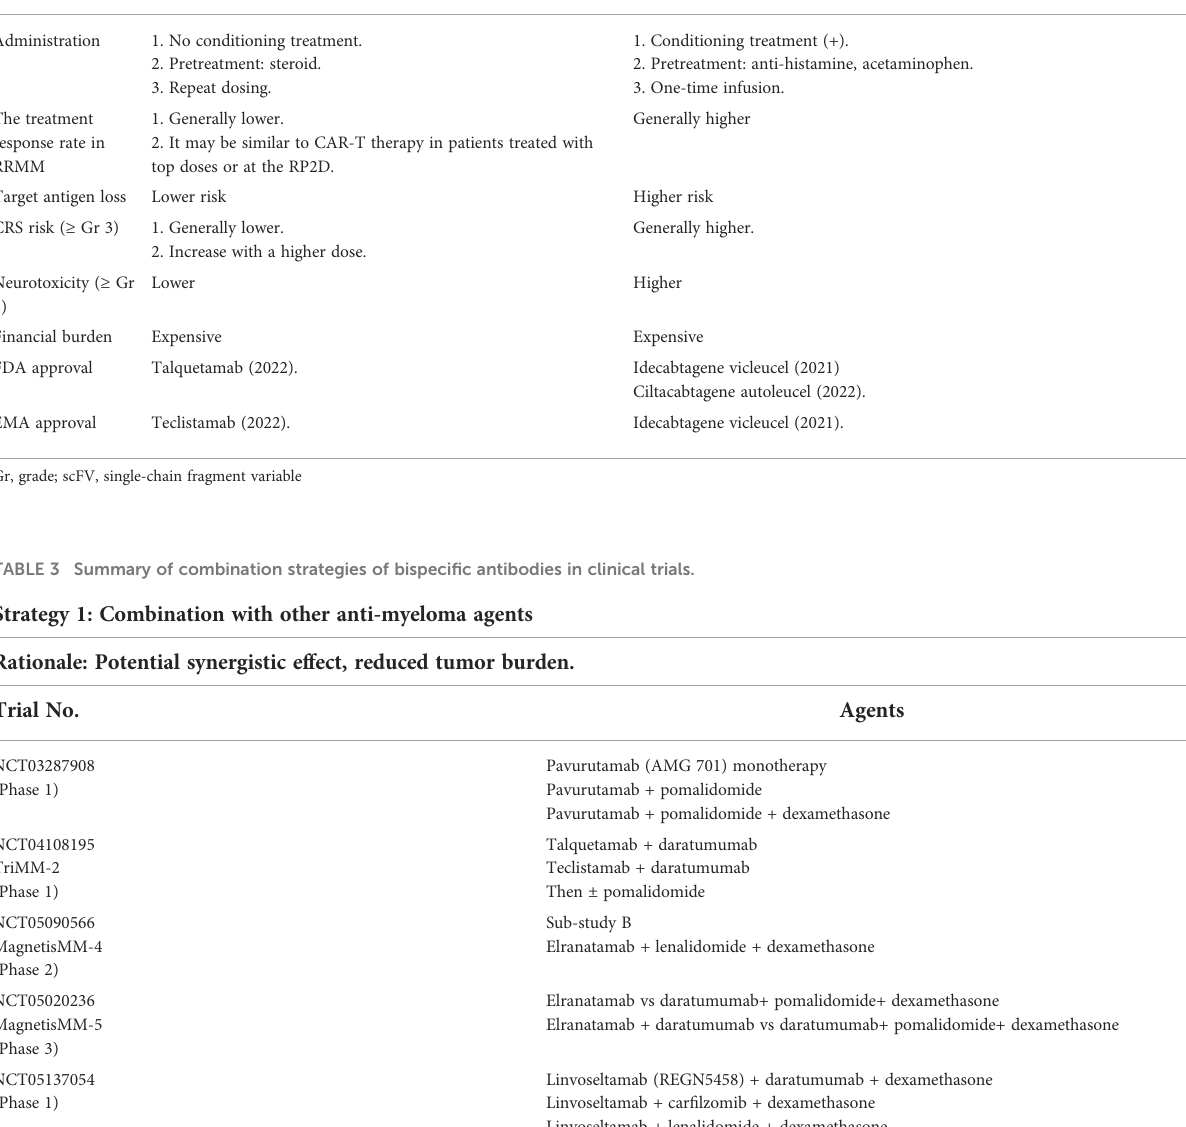
Strategy 2: Combination of 2 bispeci fi c molecules targeting various MM antigens Rationale: To reduce the risk of antigen loss related disease